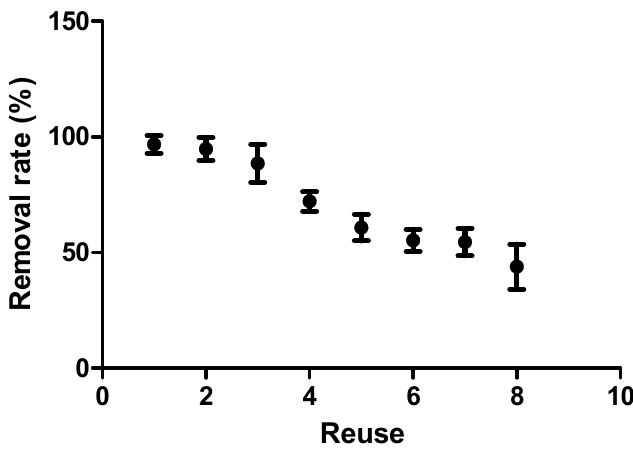
Figure 10. Reusability of the immobilized laccase.